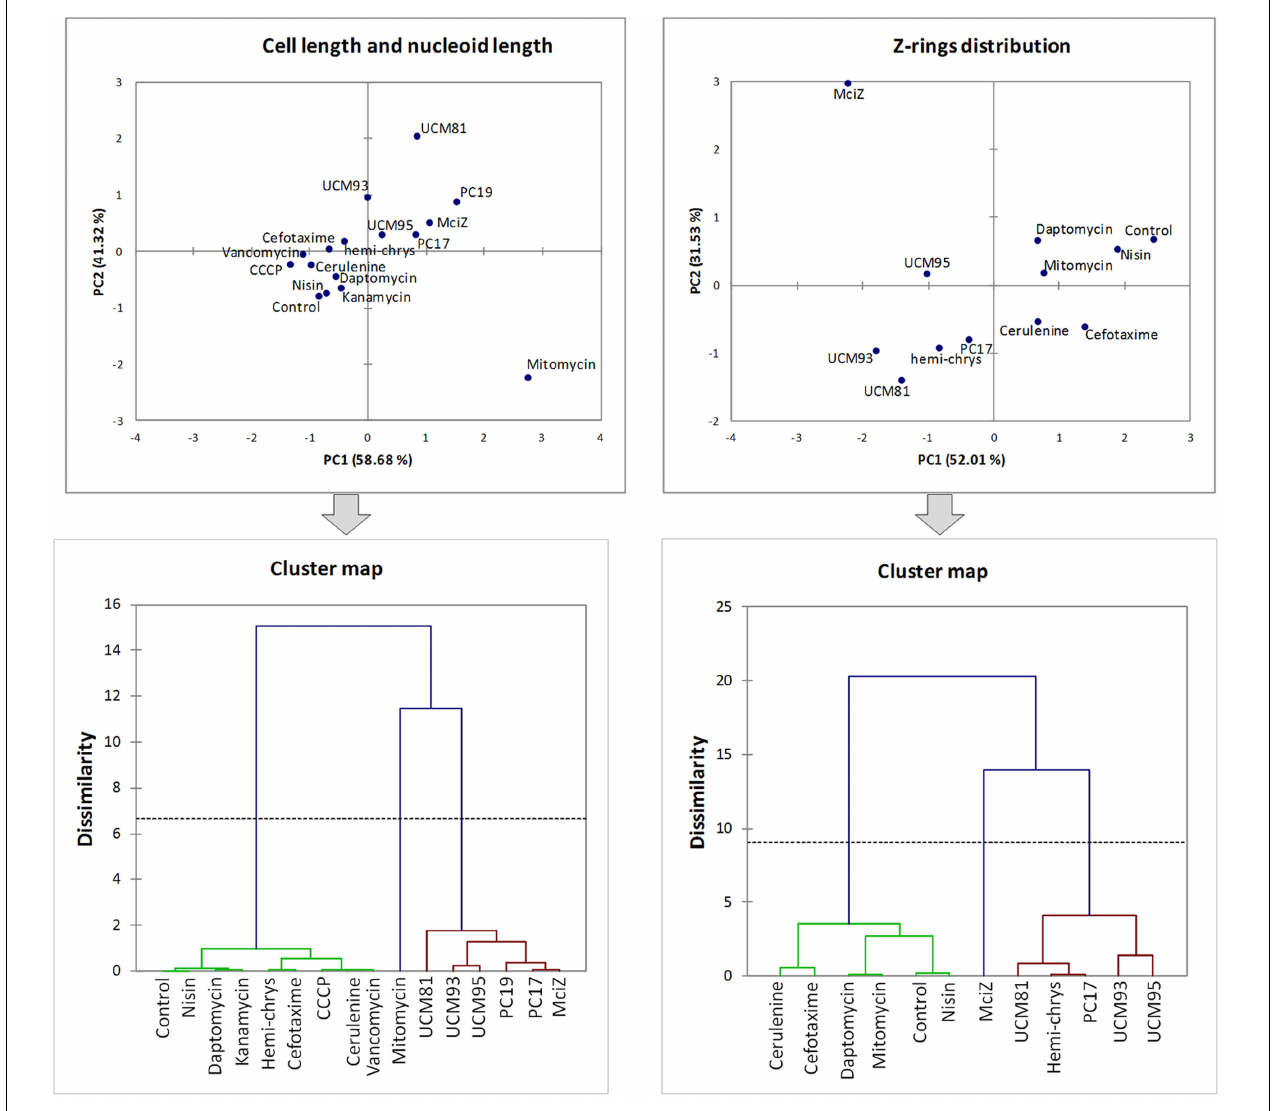
FIGURE 8 | Principal component analysis (PCA) results. PCA graphs showing PC1 and PC2, using unweighted variables cell length and nucleoid length (left graph) or Z-rings distribution (right graph). Lower graphs correspond to dendrograms obtained after a hierarchical cluster analysis based on PC values from the